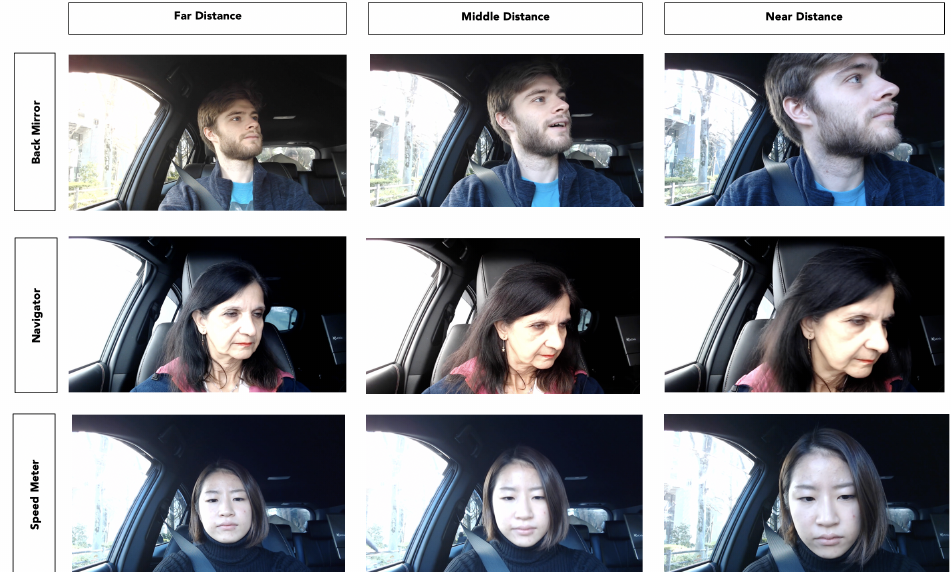
Figure 5. Rows from top to bottom: Driver’s face facing back-mirror, driver’s face facing navigator, driver’s face facing speed-meter. Columns from left to right: Driver’s face facing front with a far distance from the camera, driver’s face facing front with a middle distance from the camera, driver’s face facing front with a near distance from the